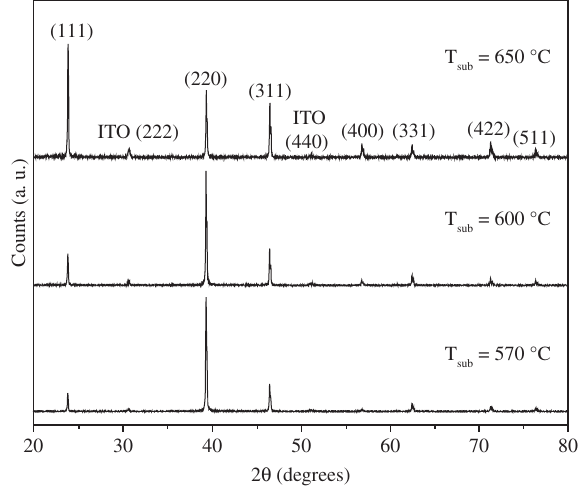
Figure 1. XRD spectra of CdTe films deposited at different substrate tem- peratures, with T = 750 °C and P = 10 Torr. so Ar